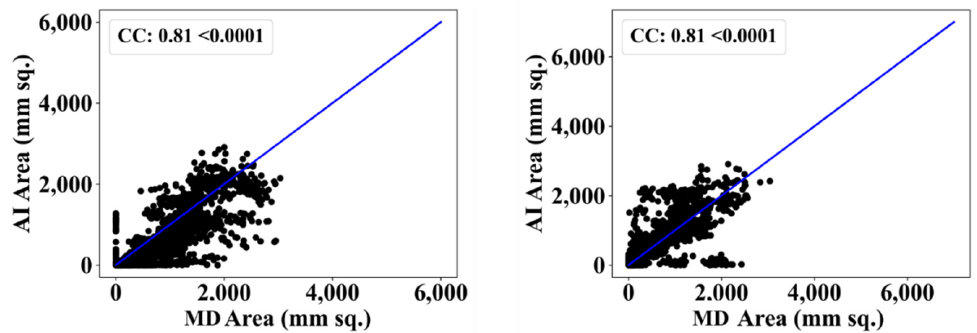
Figure 22. Correlation coefficient plots for ( left ) VGG-UNet vs. MD 1 and ( right ) VGG-UNet vs. MD 2.